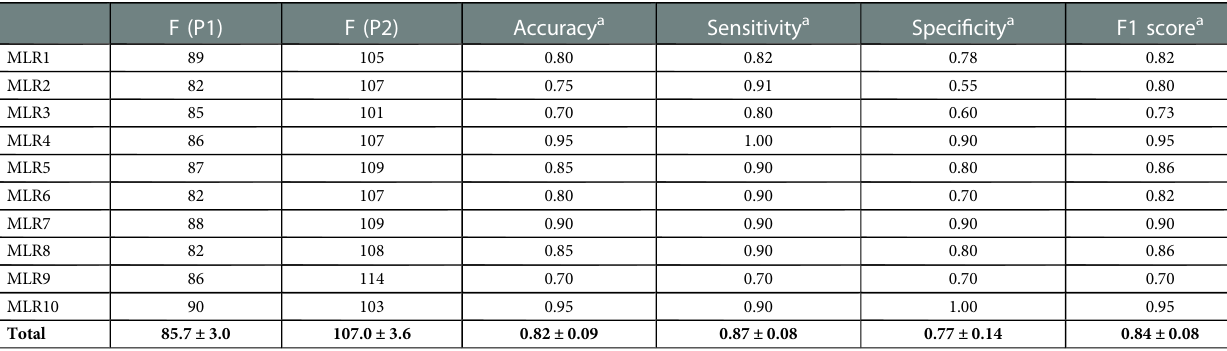
TABLE 3 Performance of the multiple logistic regression (MLR) model in 10